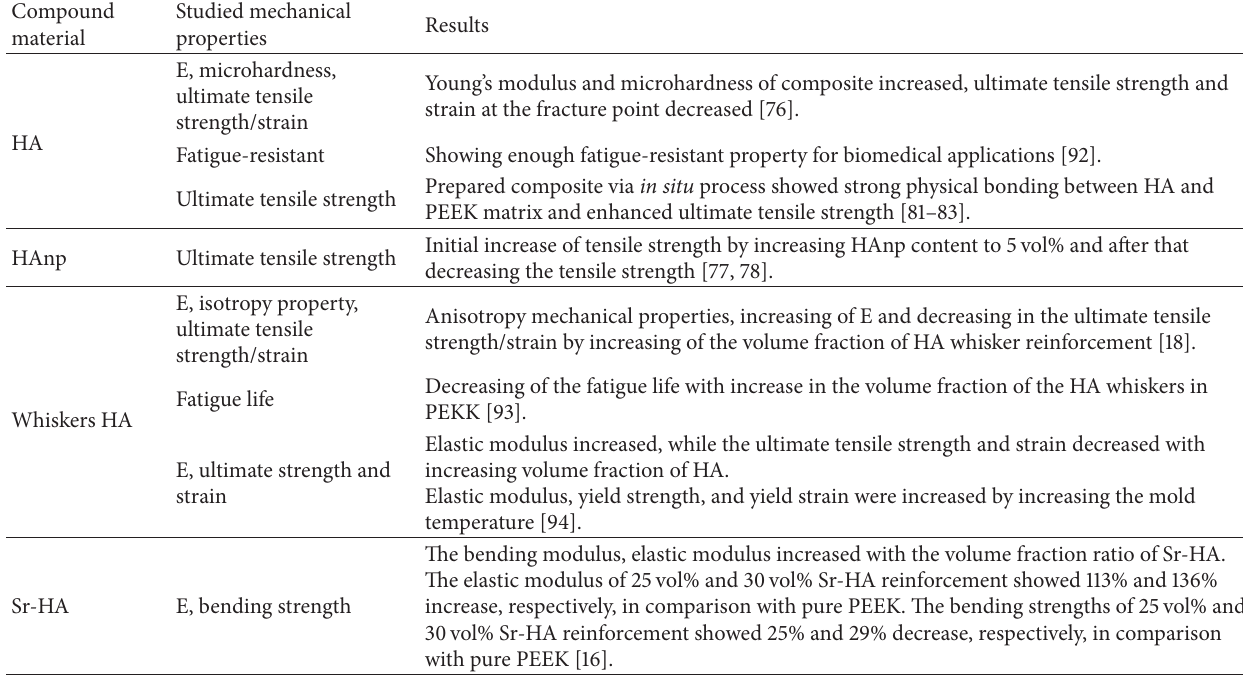
Table 5: Effect of the compound materials on the mechanical properties of the PEEK